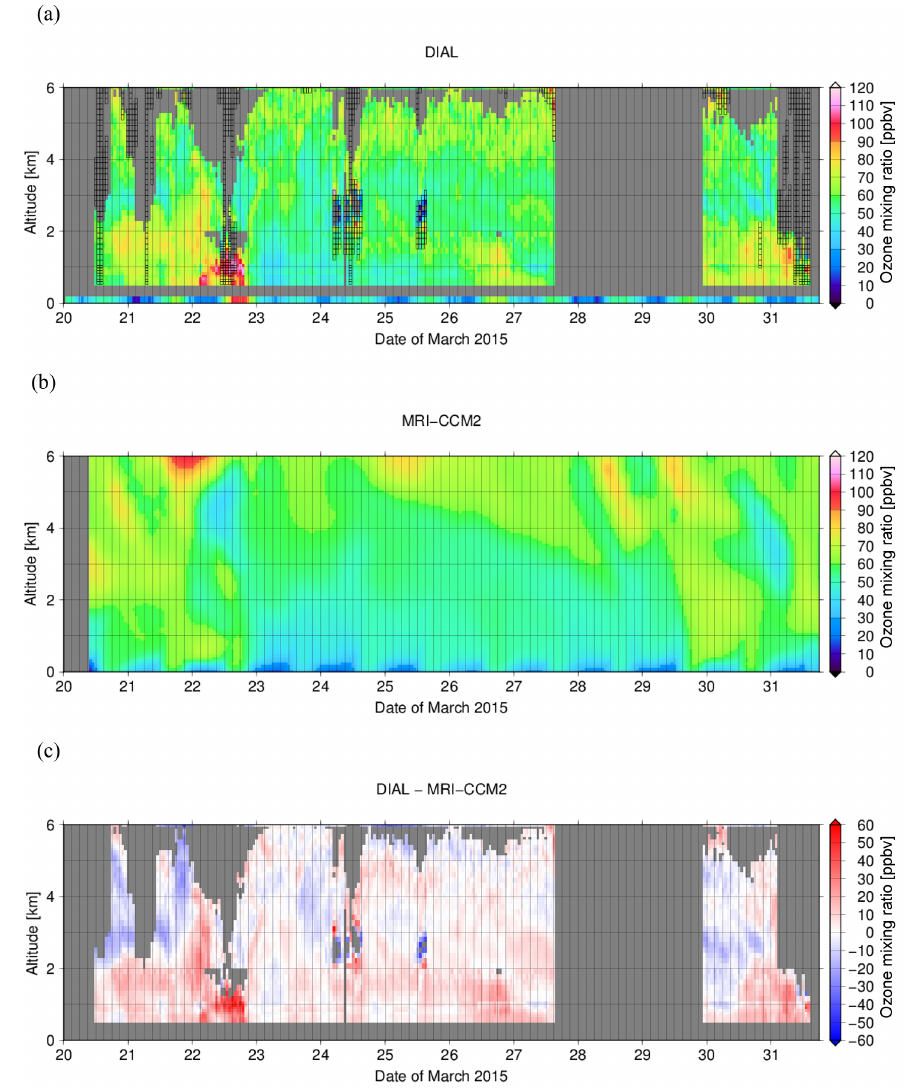
Figure 2. Time–altitude cross sections of (a) ozone volume mixing ratios observed by DIAL over Saga from 11:10JST on 20 March to 14:33JST on 31 March 2015, (b) the ratios simulated by a modified MRI-CCM2 for 20–31 March 2015, and (c) the difference between the observed and simulated ozone volume mixing ratios (a–b) . Gray regions indicate areas where there were no observational data or the statistical errors were larger than 10%. Regions enclosed with black rectangles are areas where the data were affected by aerosols and/or clouds. The lowest row in (a) shows photochemical oxidant (ozone) volume mixing ratios at Takagimachi in Saga as measured by the Saga Prefectural Environmental Research